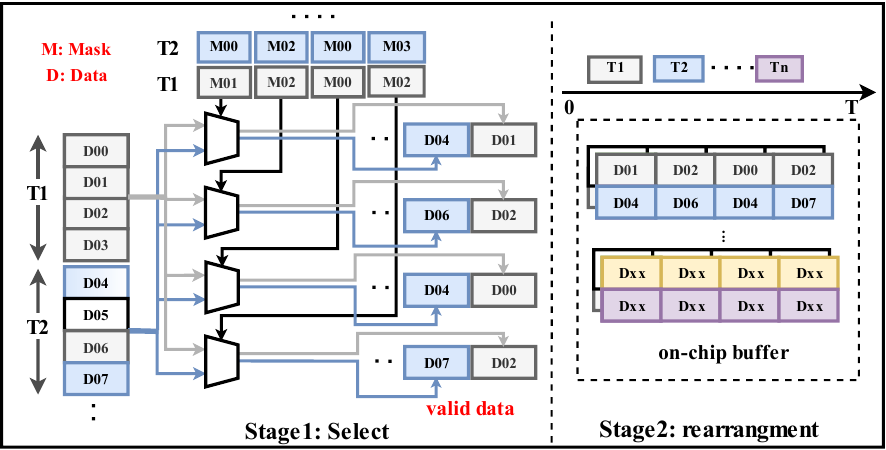
Figure 8. The schematic diagram of sparse preprocessing module.